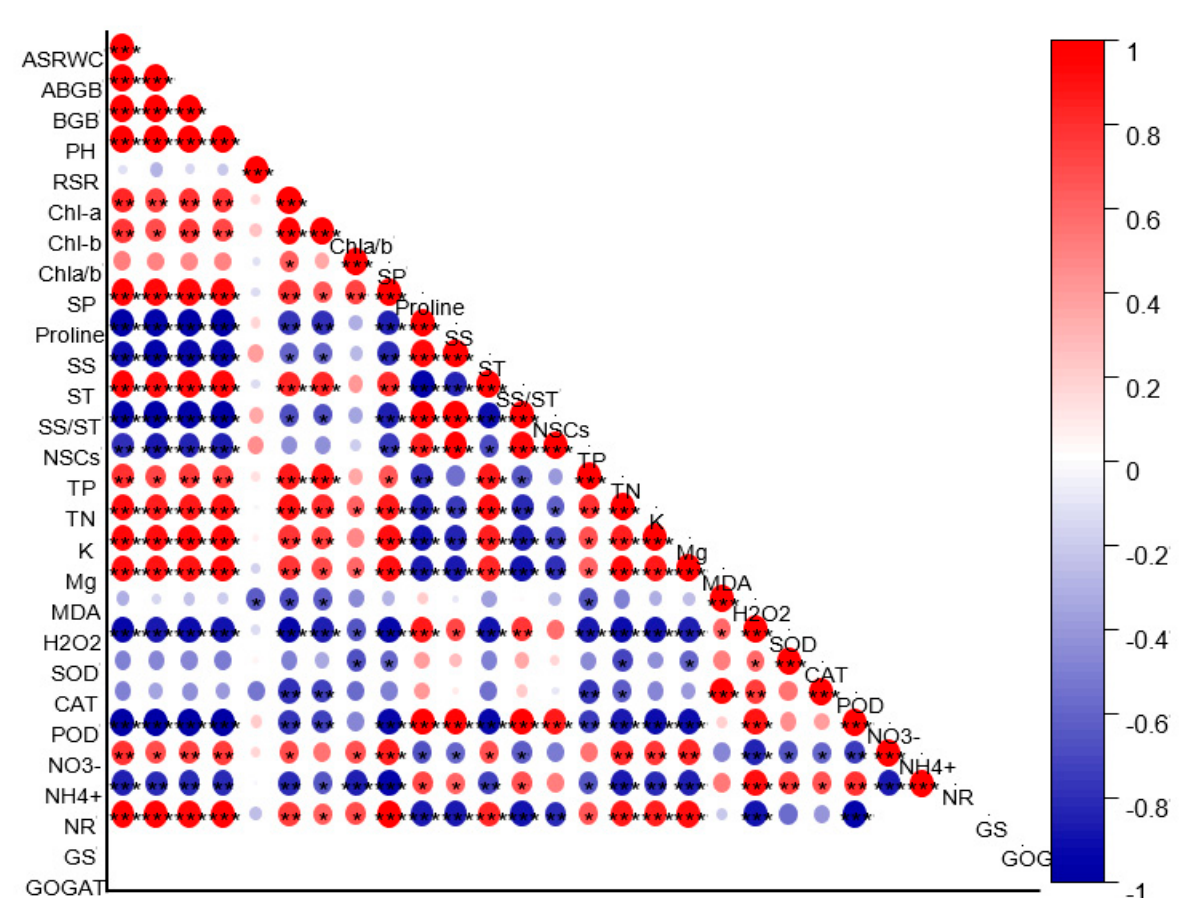
Figure 9. Pearson correlation analysis between study parameters. Assimilative shoots RWC (relative water content), ABGB (above ‑ ground biomass), BGB (below ‑ ground biomass), PH (plant height), RSR (root ‑ shoot ratio), Chl − a (chlorophyll a ), Chl − b chlorophyll b , Chla/ b (chlorophyll a / b ratio), SP (soluble protein), proline SS (soluble sugar), ST (starch), SS/ST (soluble sugar/starch ratio), NSCs (nonstructural carbohydrates), TP (Total P), TN (total N), K (potassium), Mg (magnesium), MDA (malondialdehyde), H 2 O 2 , (hydrogen peroxide), SOD (superoxide dismutase),CAT (catalase), POD (peroxidase), NO 3 − (nitrate), NH 4+ (ammonium), NR (nitrate reductase), GS (glutamine synthetase), GOGAT (glutamine oxoglutarate aminotransferase). * p ≤ 0.05, ** p ≤ 0.01, *** p ≤ 0.001.